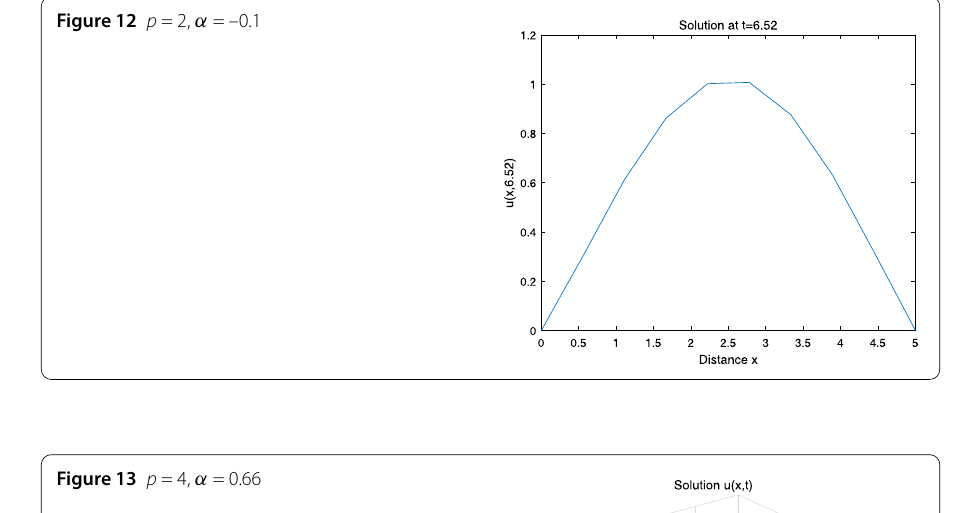
Figure 12 p = 2, α = –0.1